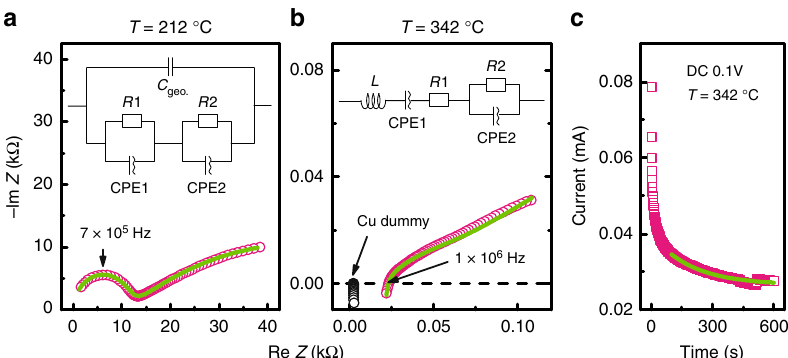
R , CPE, and L are parasitic capacitance, resistance, geo ,